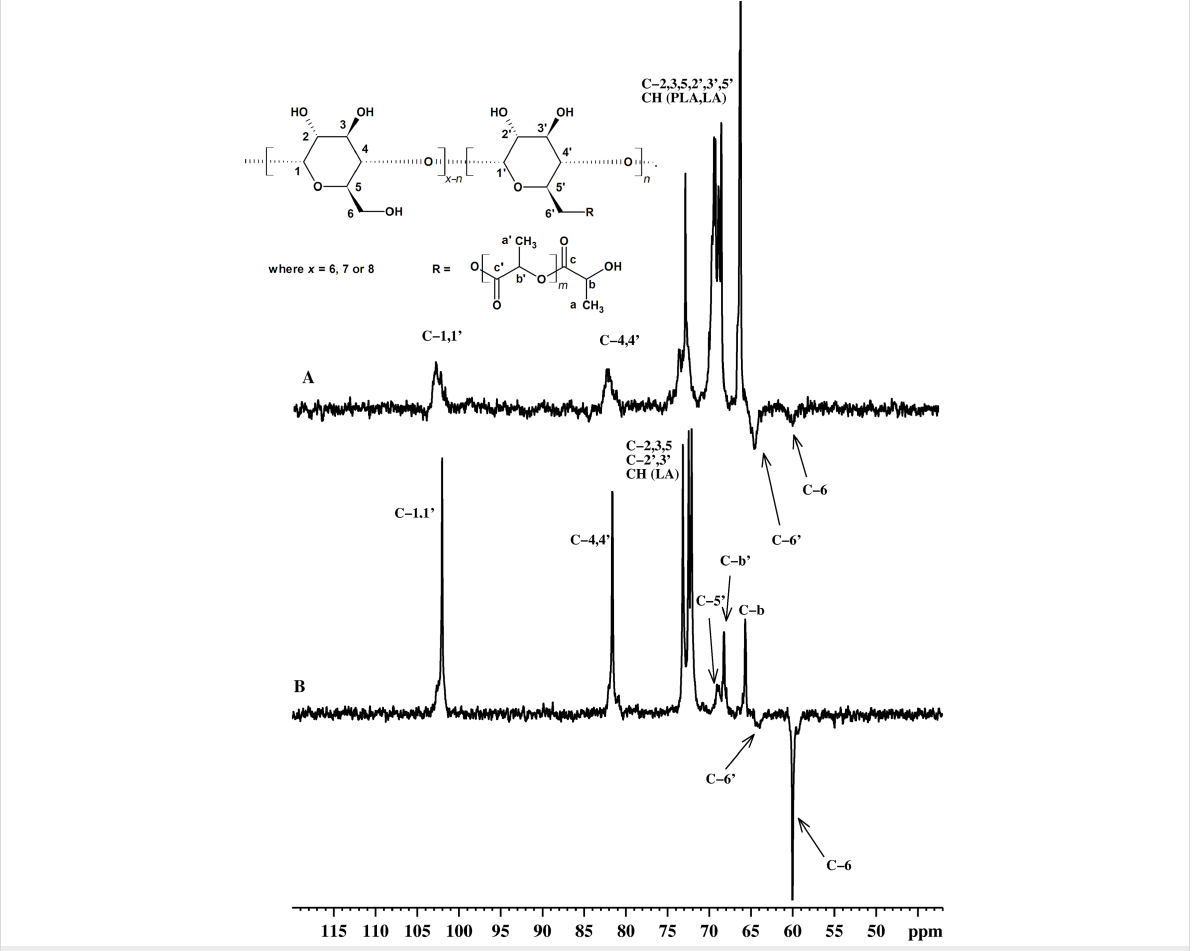
Figure 6: DEPT135-NMR experiment of (A) β -CD-LA F2 fraction and (B) β -CD-LA F1 fraction.